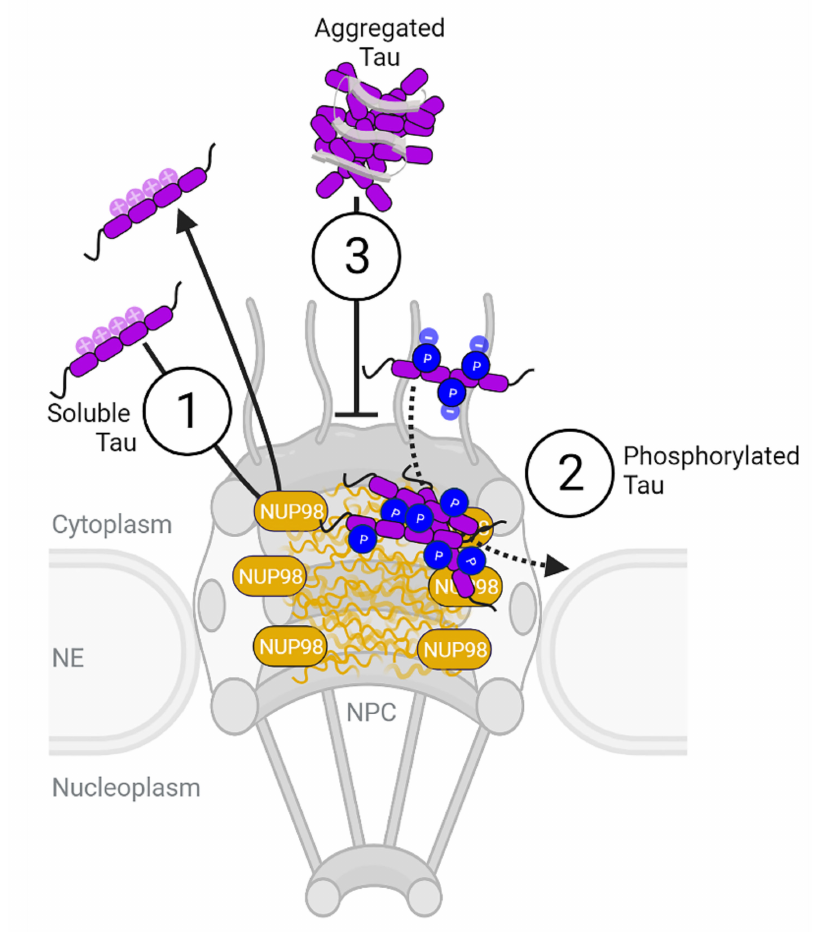
Figure 5. Potential interactions of Tau with Nup98-FG in NPCs. When coming in proximity of the nuclear envelope, e.g., upon stress-induced missorting into the neuronal somatodendritic com- partment, Tau can come in contact with NPCs. Here, Tau can interact with the disordered peptide chains of FG-Nups, including Nup98-FG, that form the permeability barrier inside the pore of the NPC. Thereby, non-phosphorylated Tau (1) interacts transiently and reversibly with the FG-Nups. In contrast, phosphorylated P-Tau (2) binds with lower affinity but more stably, which leads to its accumulation with Nup98-FG. Importantly, most—if not all—Tau close to the nucleus of neurons is phosphorylated and, thus, can accumulate with the FG-Nups. Similar observations were made in postmortem human AD brains, where phosphorylated Tau forms a layer around nuclei at the nuclear envelope. Whether P-Tau accumulation with the FG-Nups has a functional purpose or is a stress/disease-associated pathological consequence of Tau missorting remains to be investigated. Tau oligomers (3), however, do not bind or accumulate with Nup98-FG, suggesting that oligomer- ization and aggregation are not essential for Tau accumulation on neuronal NPCs in AD (created with